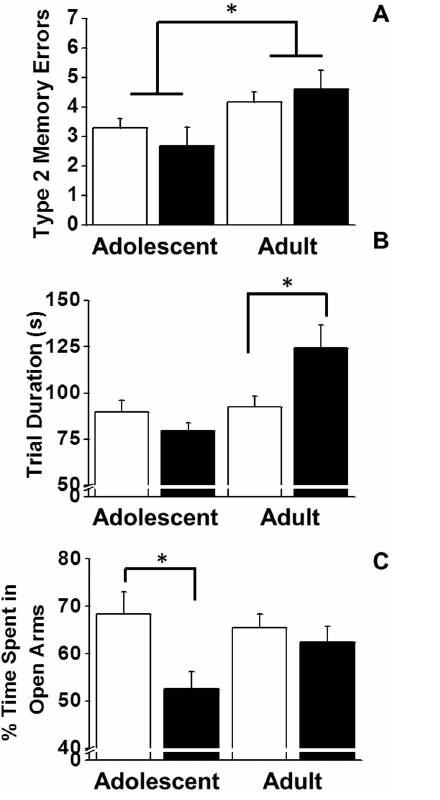
Figure 4. Effects of chronic intermittent ethanol (black bars) or saline (white bars) exposure during adolescence or adulthood after the 6 h delay in DNMTP. Data on type2 working memory errors (panel, A), trial duration (panel, B) and%time spent in the open arms (panel C) are expressed as group mean 6 SEM (n=5 adolescent saline, n=5 adolescent CIE, n=5 young adult saline, n=7 young adult CIE, n=6 adult saline, n=6 adult CIE). Asterisk denotes a significant age difference when collapsed over treatment (panel A) and a significant difference between animals treated in adulthood with ethanol vs. saline (panel B). ( Post-hoc t-test, p , 0.05).